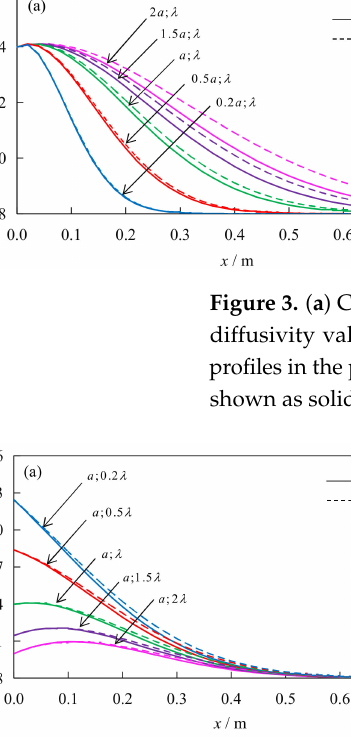
Figure 4. ( a ) Comparison of temperature in the presence of temperature source for different coef- ficients of the cooling ratio with fixed thermal diffusivity at t = 11 h. ( b ) Variation of temperature profiles in the presence of temperature source at x = 0.2 m. The analytical and numerical solutions are shown as solid and dotted lines,